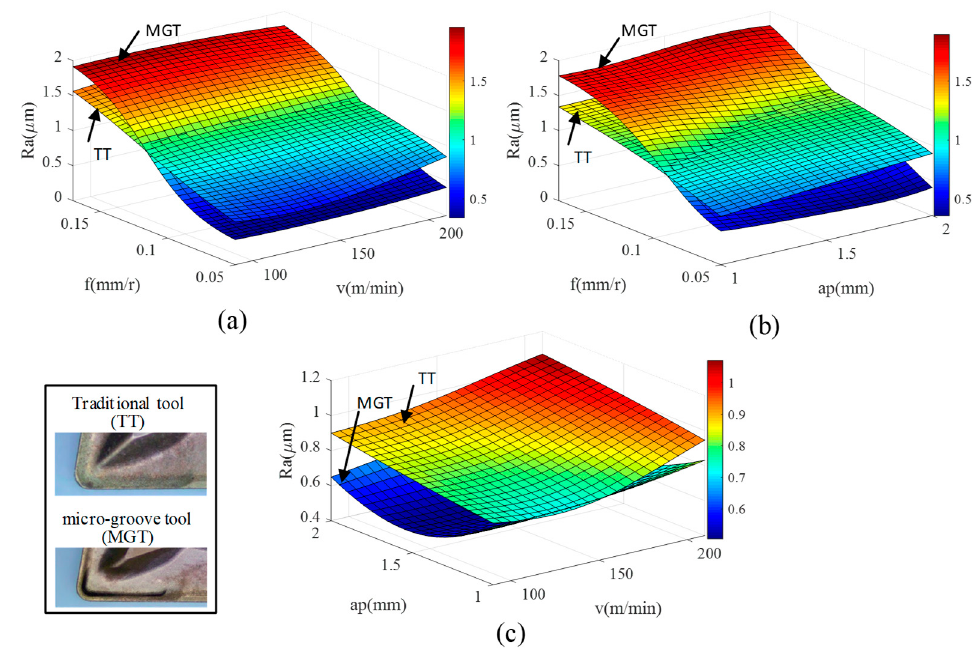
Figure 16. Surface roughness as a function of cutting parameters, ( a ) ap is a constant equal to 1.5 mm, ( b ) v is a constant equal to 120 m/min, ( c ) f is a constant equal to 0.08 mm.